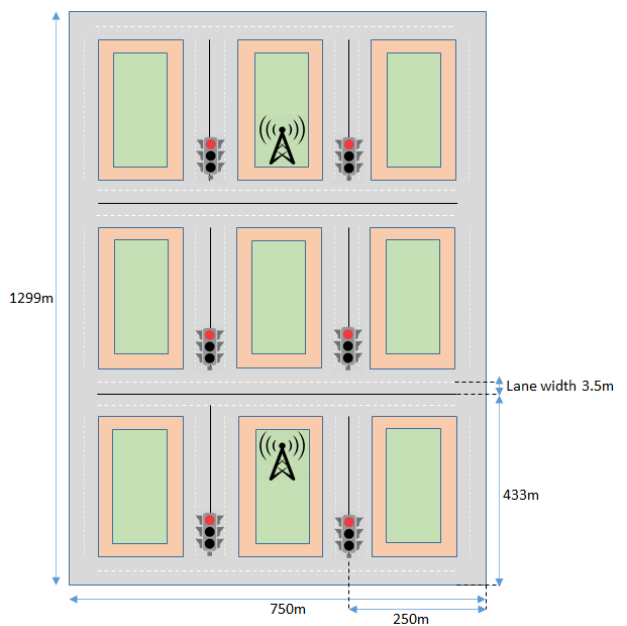
Figure 3. 3GPP’s road configuration for Urban Grid.